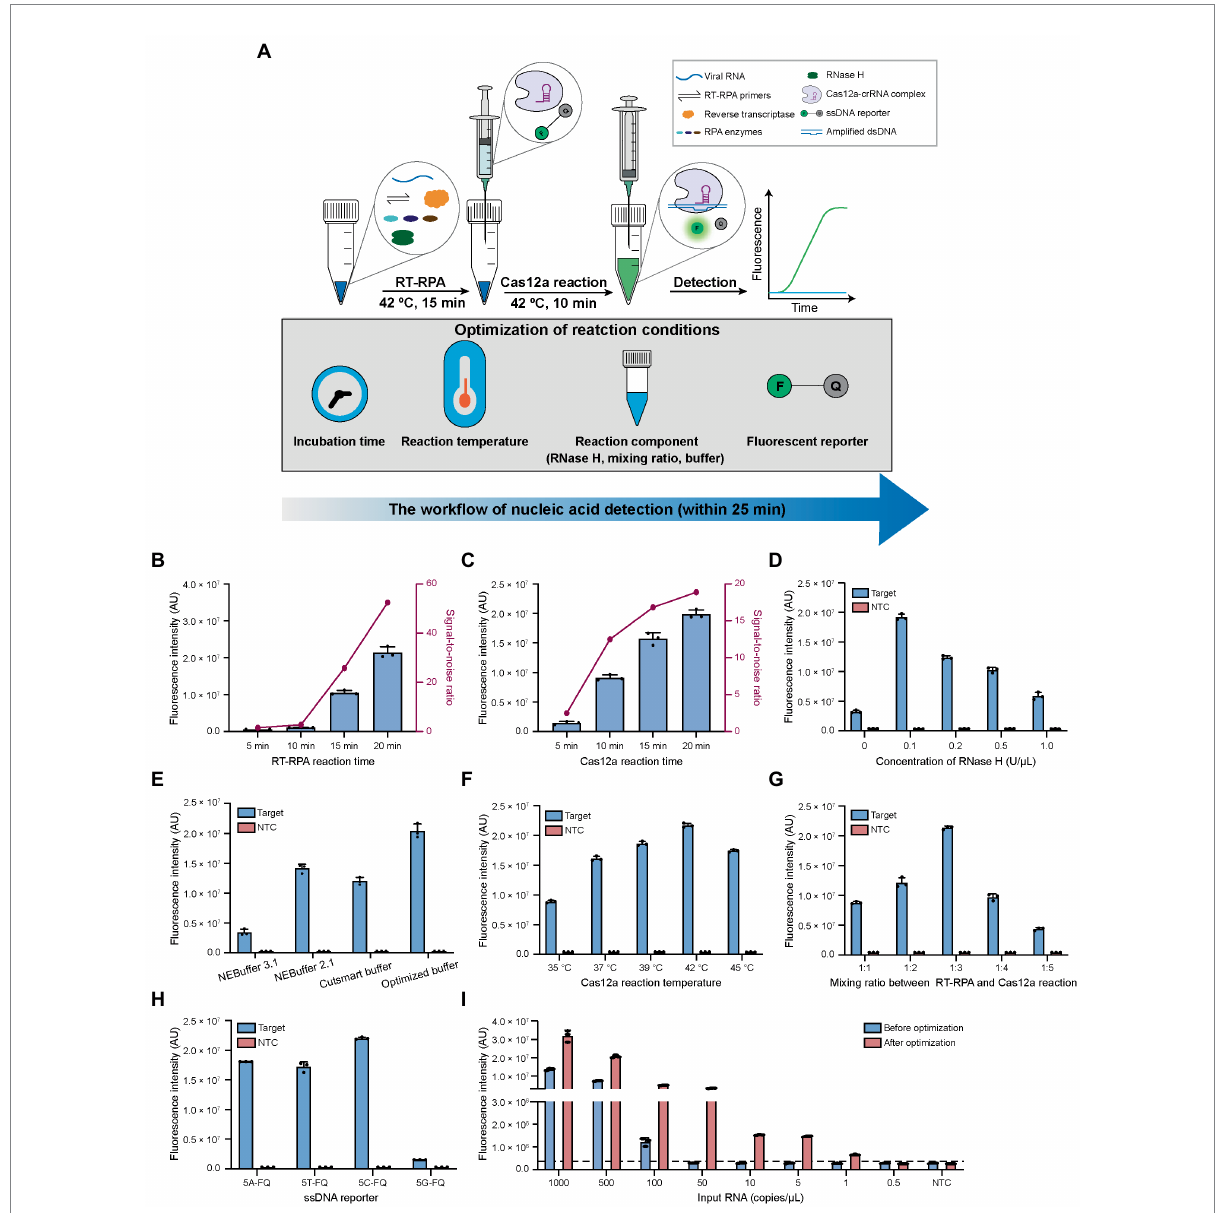
FIGURE 2 Optimization of the reaction conditions for CALIBURN-v2. (A) Schematic presentation of CALIBURN-v2 for closed-lid pathogen detection, showing reaction conditions to be optimized. (B,C) The effects of incubation time of RT-RPA (B) and Cas12a (C) reaction on the final signal readout. (D) Screening the optimal concentrations for RNase H. (E) Comparison of the assay efficiency using different Cas12a reaction buffers. (F–H) Effect of Cas12a reaction temperature (F) , the mixing ratio between RT-RPA and Cas12a reaction (G) , and the sequences of ssDNA reporters (H) on the assay performance. (I) Comparison of the sensitivity of the assay before and after optimization. The black dotted line represents the threshold, which is set as the mean of NTC plus 3-fold standard deviation (SD). Target, SARS-CoV-2 IVT N gene RNA (1 nM). NTC, non-template control. The data from three biological replicates are shown as mean ±